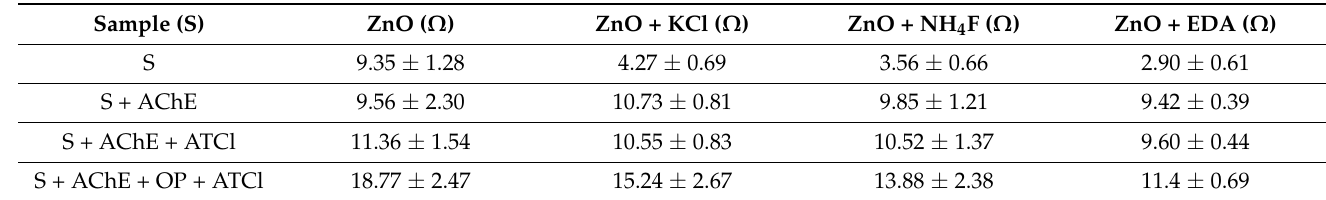
Table 1. Rct values obtained from EIS measurements for ZnO samples on carbon